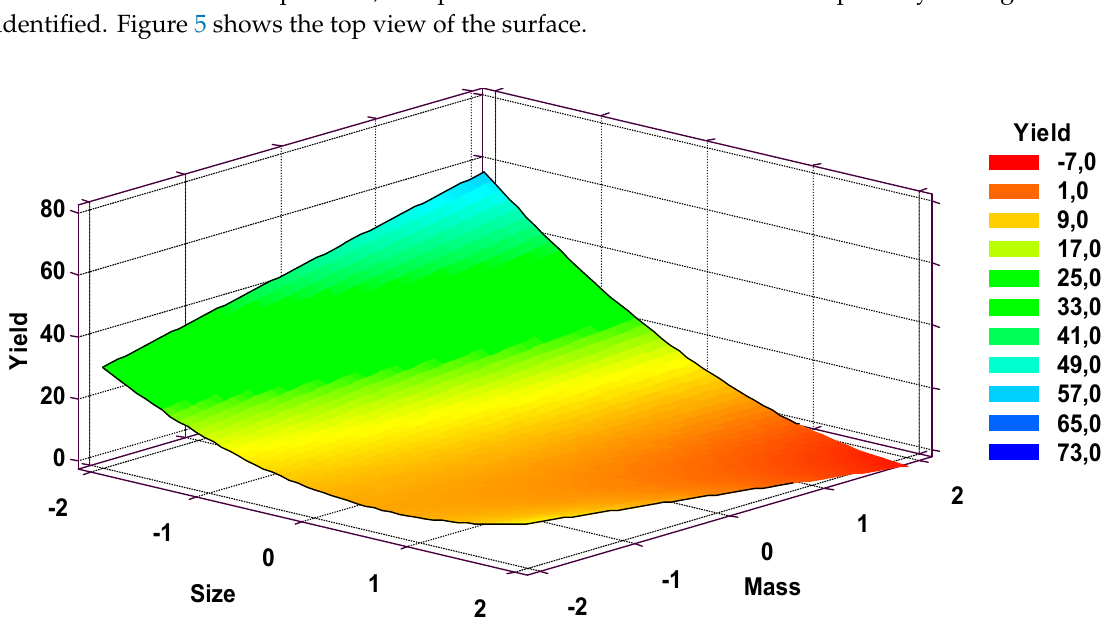
Figure 4. Normal probability plot of obtained residuals.